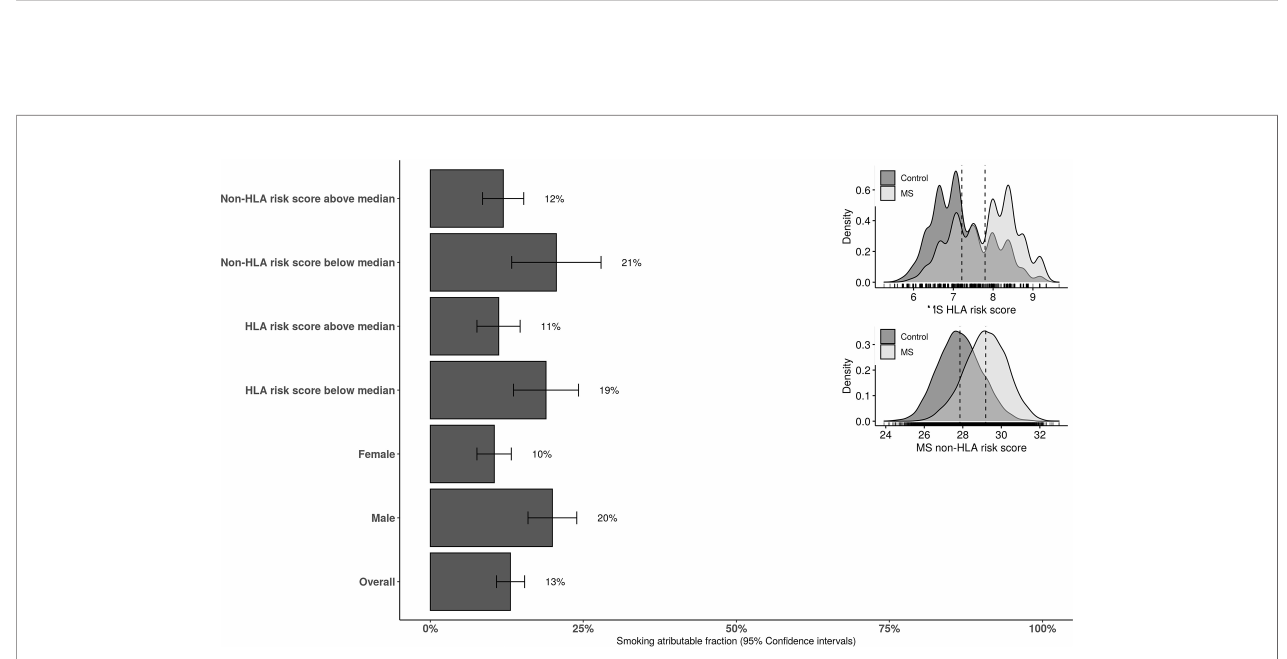
FIGURE 2 | The overall and strati fi ed smoking attributable fraction (95% con fi dence intervals) for risk of MS. HLA and non-HLA risk scores are categorized to below and above the median score in the population-based controls. HLA, human leucocyte